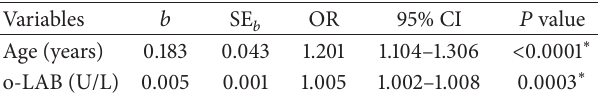
Table 3: Logistic regression analysis (stepwise method) of factors related to CRC presence. Serum o-LAB and age as independent variables; 𝑏 : regression coefficient; SE 𝑏 : standard error of 𝑏 ; OR: odds ratio; 95% CI: 95% confidence